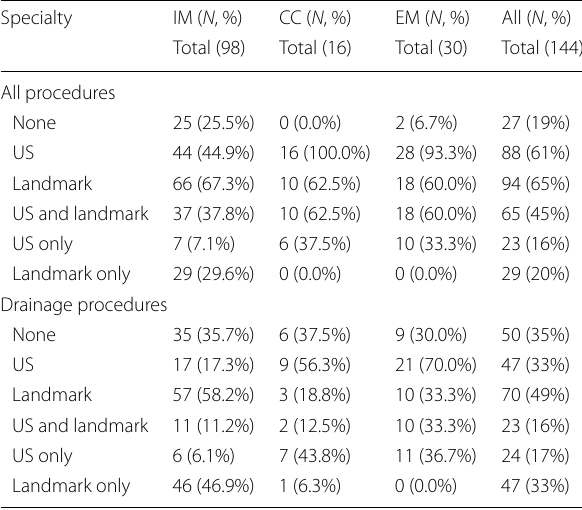
Table 4 Residents’ procedural experience: combined procedural experience with and without ultrasound guidance